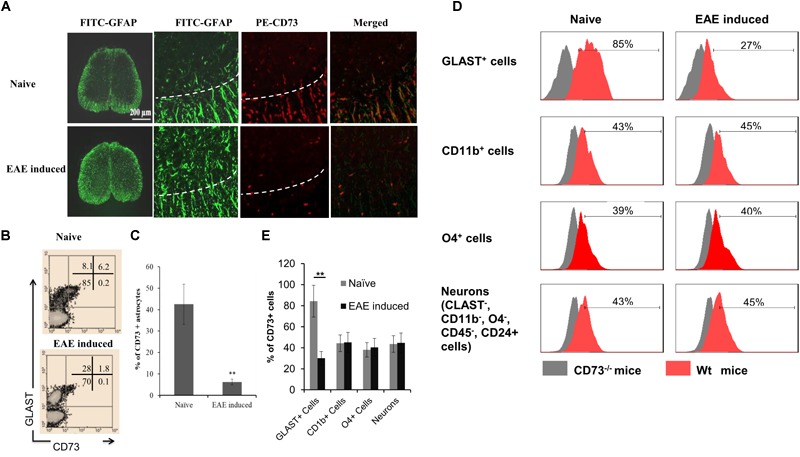
Downregulated CD73 expression in EAE-astrocytes. Spinal cords were isolated from naïve and EAE-induced B6 mice, and the samples were fixed, embedded, and sectioned. Sections were fluorescence stained with GFAP (green fluorescence) and CD73 (red fluorescence). A single cell suspension was prepared from the brains of naïve and EAE-induced B6 mice. The percentage of CD73+ cells in total GLAST+ cells was analyzed by flow cytometry. Thereafter, astrocytes, microglial cells and oligodendritic cells were individually labeled with anti-mouse GLAST, O4, and CD11b antibodies, respectively, while neurons were defined as the GLAST-CD11b-O4-CD45-CD24+ population. The fluorescence density of CD73 in these four types of cells was evaluated, with CD73-/- mice as a control. ∗∗Indicates statistically significant differences (p < 0.01). (A) Immunohistological staining of spinal cord sections from naïve and EAE mice. (B) Flow cytometry analysis of CD73+ and GLAST+ cells in a single cell suspension prepared from brains. (C) The percentage of CD73+ cells in total GLAST+ cells (n = 6). (D) Fluorescence density of an anti-CD73 PE-conjugated antibody in different types of brain cells from naïve and EAE-induced mice. (E) The percentage of CD73+ cells in different types of neural cells from naïve and EAE-induced mice (n = 6).